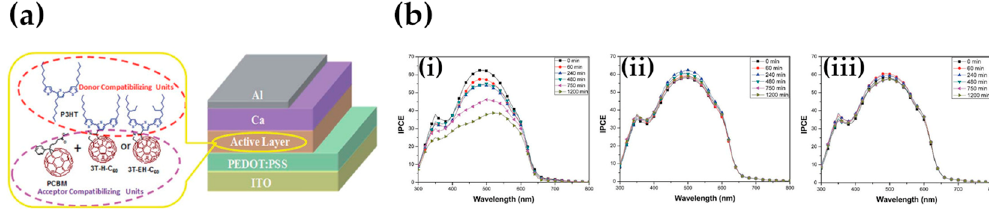
Figure 12. Terthiophene-C 60 dyads compatibilizers. ( a ) Fulleropyrrolidine derivatives